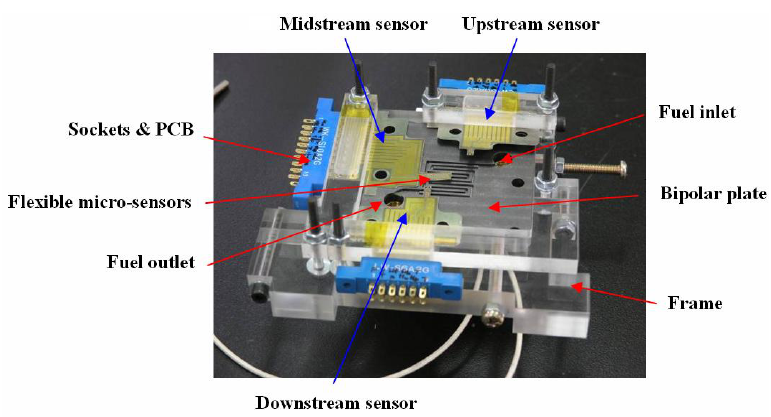
Figure 7. In-situ diagnostic device embedded in a PEM fuel